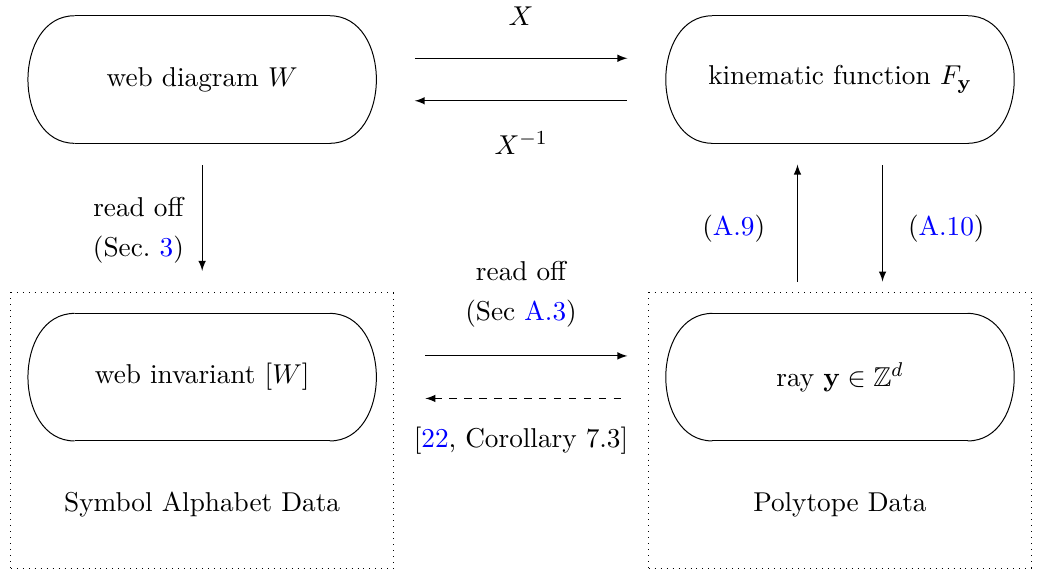
Figure 2. An outline of how our work fits into the literature. Recent studies have uncovered an apparent connection between data associated to the facets (with normal ray y ) of certain G(4 , n ) - polytopes (indicated on the second column) and the symbol alphabet of n -particle amplitudes in SYM theory (left column). One route from the former to the latter [7] (the dotted line) uses the character formula of [22] and requires the series (2.3) to be computed term by term, with the m - th term having computational complexity O (( mw )!) , where w is an integer that depends on the